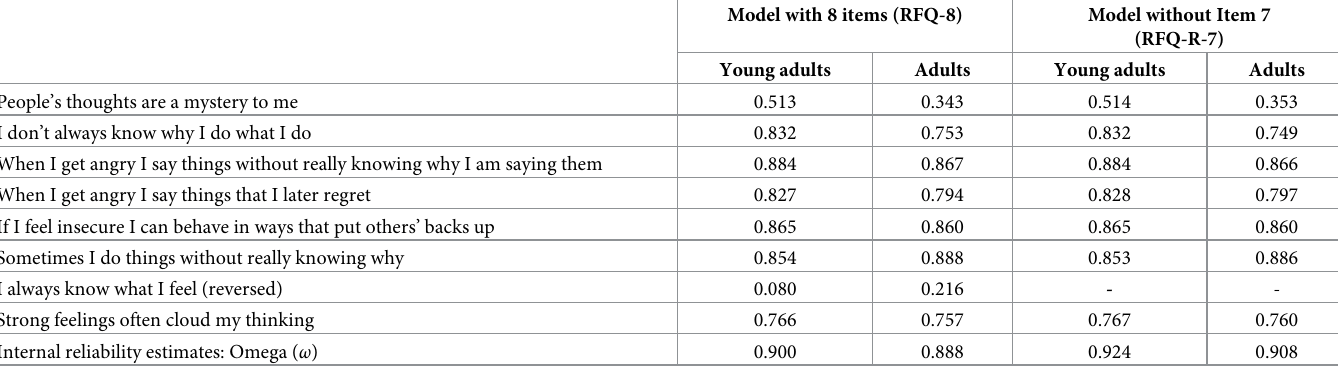
Table 2. Factor loadings and internal reliability estimates of the one-factor model of the RFQ-8 and the